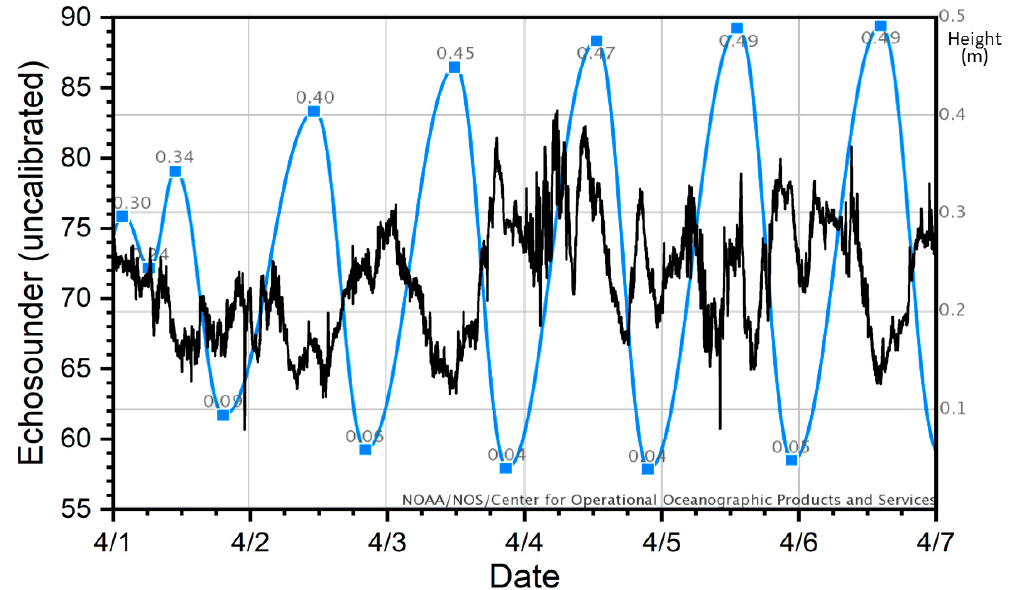
Figure 12. Bottom echo intensity data (average values over the bottom 2 m of the water column) vs. time, from the ADCP at mooring BP2. Tidal stage is indicated by the blue line (right axis, water height in m above Mean Lower-Low Water datum, from the NOAA Tides and Currents web page, Horn Island station 8742221: https://tidesandcurrents.noaa.gov/noaatidepredictions.html?id=8742221). Times indicated are local (UTC –5 h).